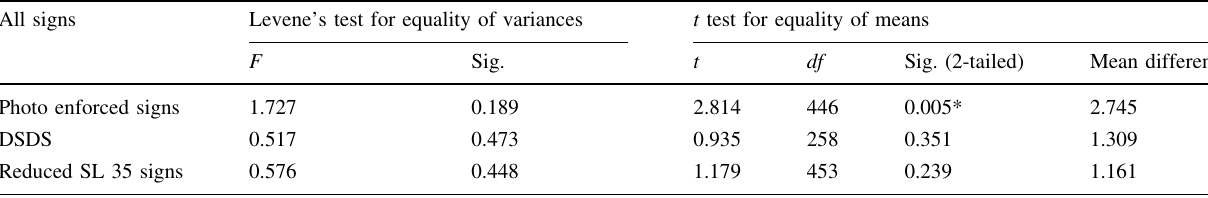
Table 8 Independent samples t test —